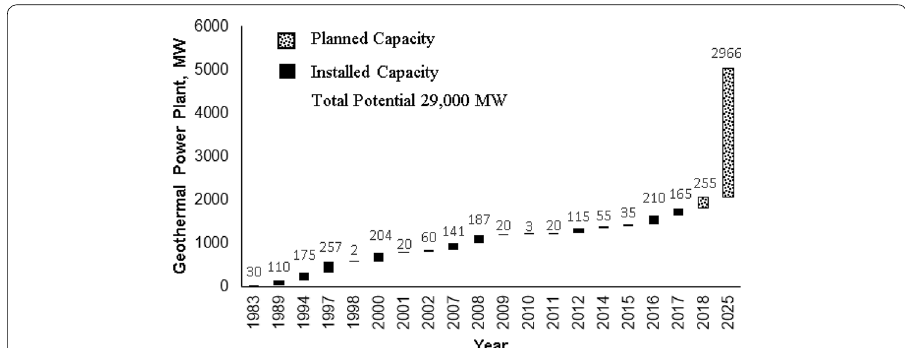
Fig. 1 Geothermal power plant generation in Indonesia: past, present and future